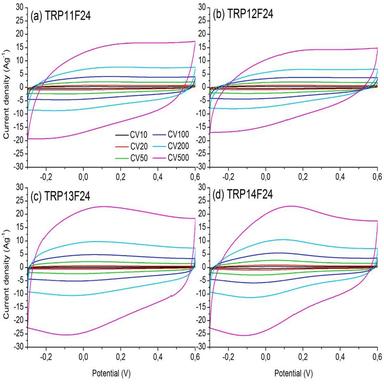
CV curves at 10, 20, 50, 100, 200 and 500 mVs− 1 of F-doped-SiO-DC materials etched during 24 h.